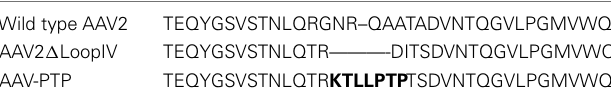
Table 1 |Amino acid sequence alignment of wild